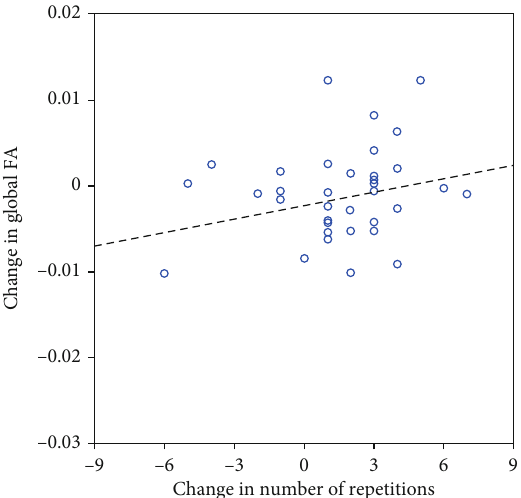
Figure 3: Relationship between change in FA and change in performance in the 30-Second Chair Stand